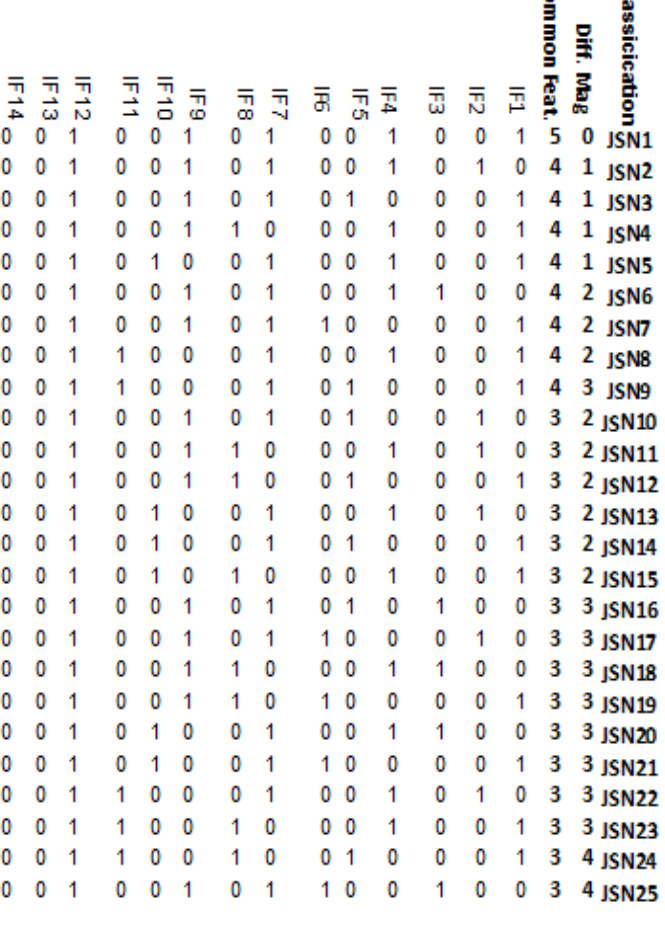
Figure 1: Mapping of Commercial Systems to